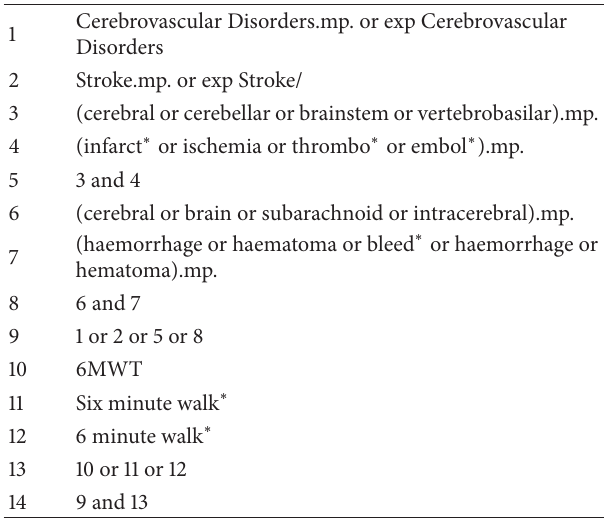
Table 1: Search strategy used for